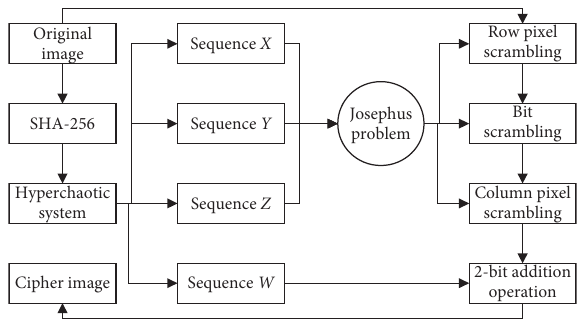
Figure 3: The flowchart of the encryption